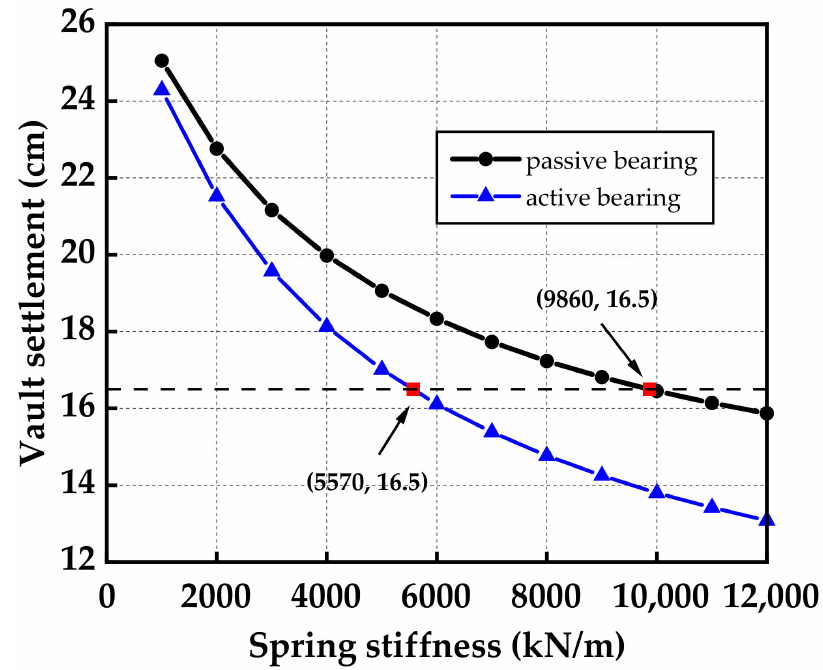
Figure 14. Comparison of the settlement of active and passive load-bearing